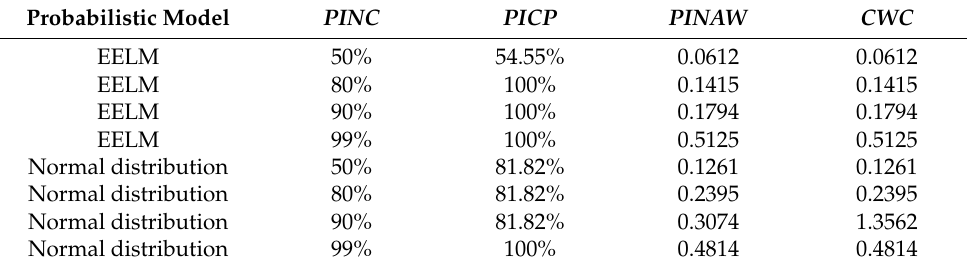
Table 5. Confidence interval evaluation index for a typical day in